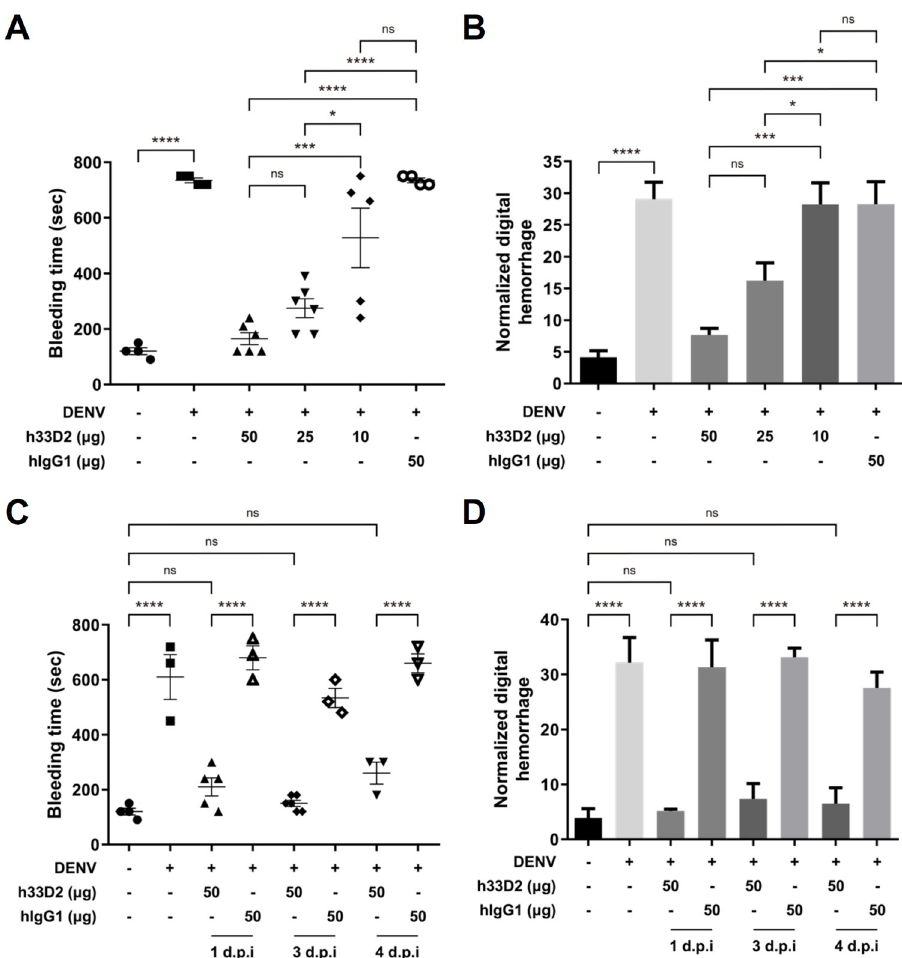
Fig 4. Dose response and time kinetics of bleeding time and hemorrhage following passive transfer of humanized anti-NS1 mAb 33D2 into DENV-infected mice. Mice were inoculated with 1 × 10 7 PFU/mouse DENV2-454009A or C6/36 control medium i.d. into the upper back of STAT1 -/- mice. ( A, B ) The mAb h33D2 (10, 25, or 50 μ g/mouse) or 50 μ g/mouse isotype control hIgG1 was injected i.p. one day after DENV challenge. ( A ) The tail bleeding time was determined on 5 d.p.i. (n = 6 for 50 μ g and 25 μ g h33D2 groups, n = 5 for 10 μ g h33D2 group, and n = 4 for other groups). ( B ) The skin hemorrhage was determined on 5 d.p.i. (n = 4 for mock and n = 5 for other groups). ( C, D ) The mAb h33D2 or isotype control hIgG1 (50 μ g/mouse) was injected i.p. 1, 3 or 4 days after DENV challenge. ( C ) The tail bleeding time was determined on 5 d.p.i. (n = 4 for mock group, n = 5 for h33D2-treated on 1 d.p.i. group, n = 6 for h33D2-treated on 3 d.p.i. group, and n = 3 for other groups) ( D ) The skin hemorrhage was determined on 5 d.p.i. (n = 4 for each group) � : p < 0.05, ��� : p < 0.001, ���� : p < 0.0001, ns indicates not significant. Statistical significance was based on one-way ANOVA followed by Tukey’s multiple comparison